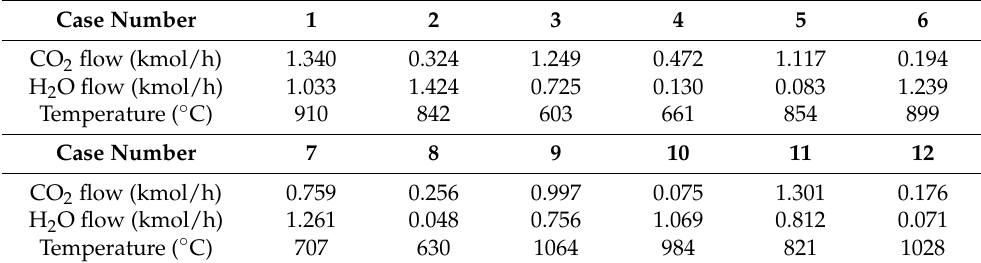
Table 2. Random cases beyond the range of training